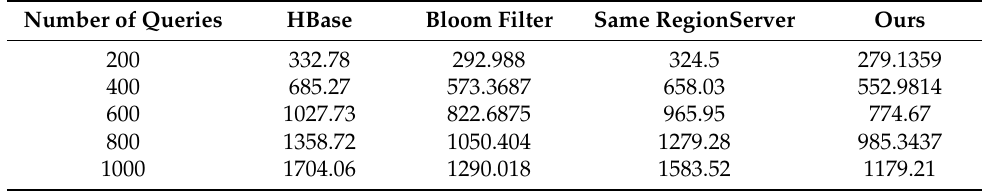
Table 1. Performance of secondary index optimization